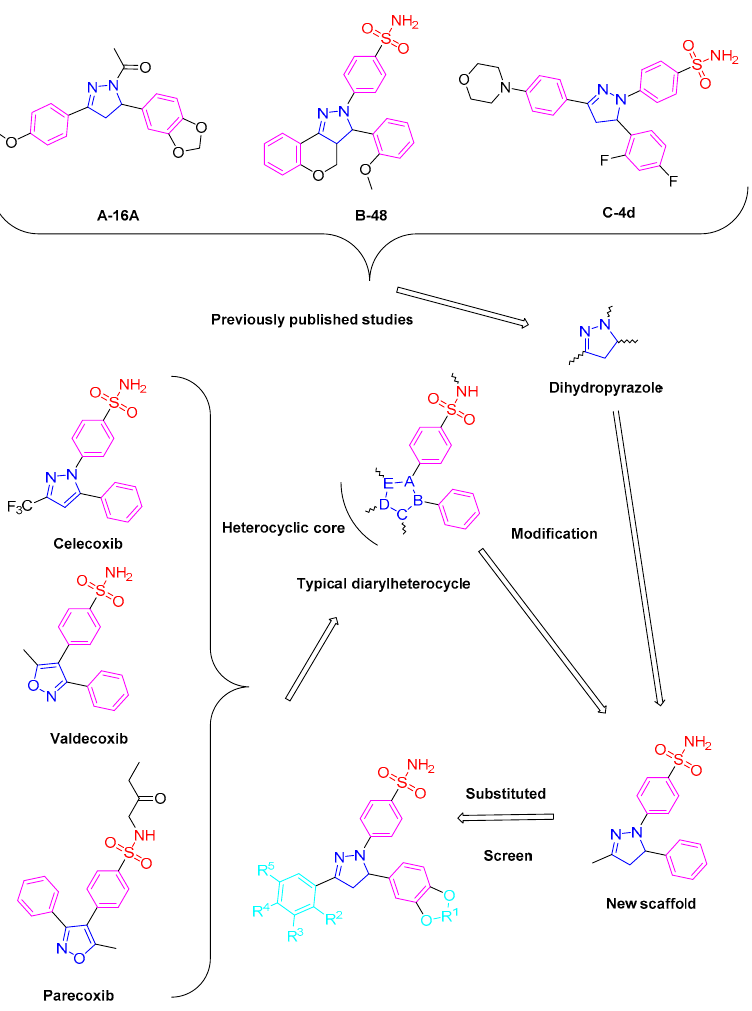
Figure 1. The design pathway for novel dihydropyrazole derivatives containing benzo oxygen heterocycle and sulfonamide moieties.